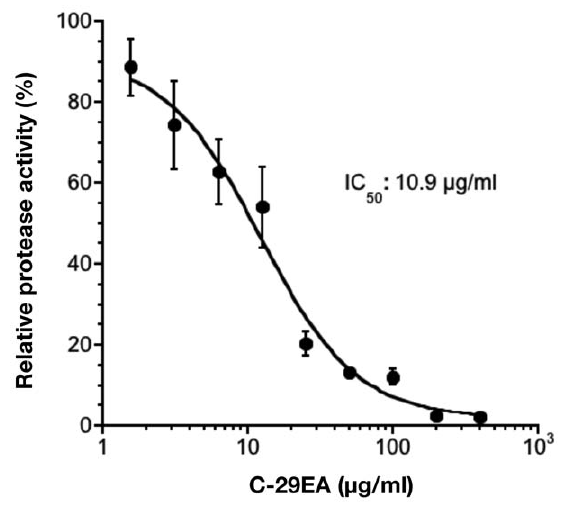
Figure 7. Effect of C-29EA on the activity of NS3 serine protease. NS3/4A serine protease was mixed with various concentra- tions of C-29EA or DMSO (0) in the reaction mixture and then incubated at 37 u C for 120 min. The initial velocity at each concentration of C-29EA was calculated during 120 min reaction. The initial velocity in the absence of C-29EA was defined as 100% of relative protease activity. The data are presented as the mean 6 standard deviation for three replicates.